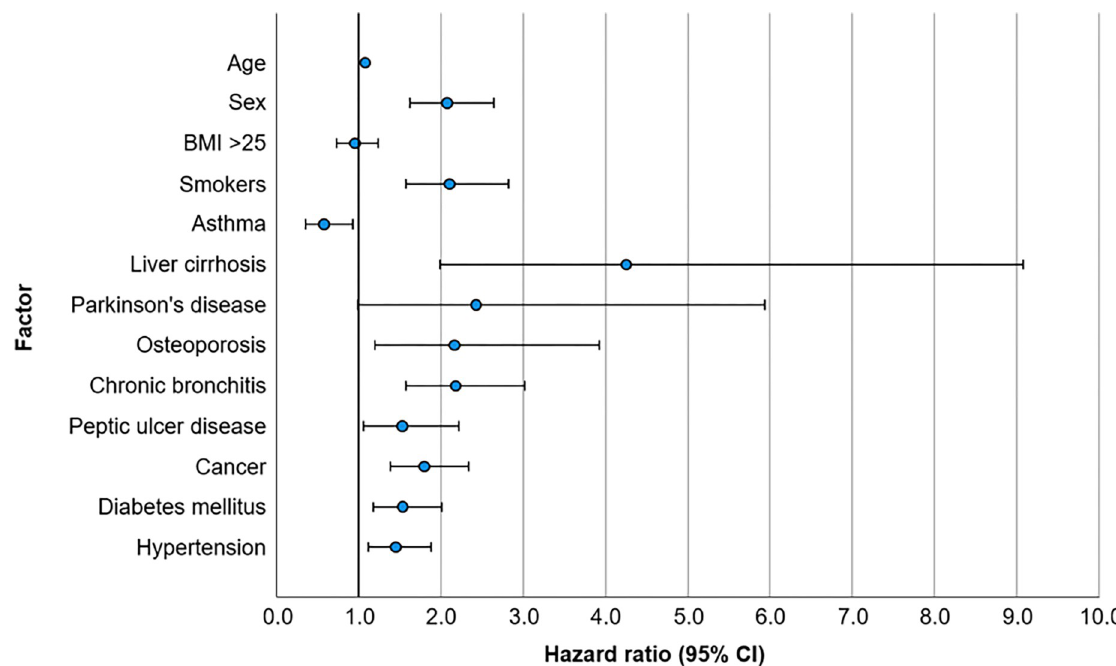
Fig 2. Comparison of risks for mortality for risk factors and selected diagnoses, according to the optimal model. Shown are the hazard ratios and 95% confidence intervals for the risk factors age, sex, BMI > 25 and smoking status and several diagnoses in the medical history of the participants of the LIFE-ADULT-Study, selected by the optimal model.